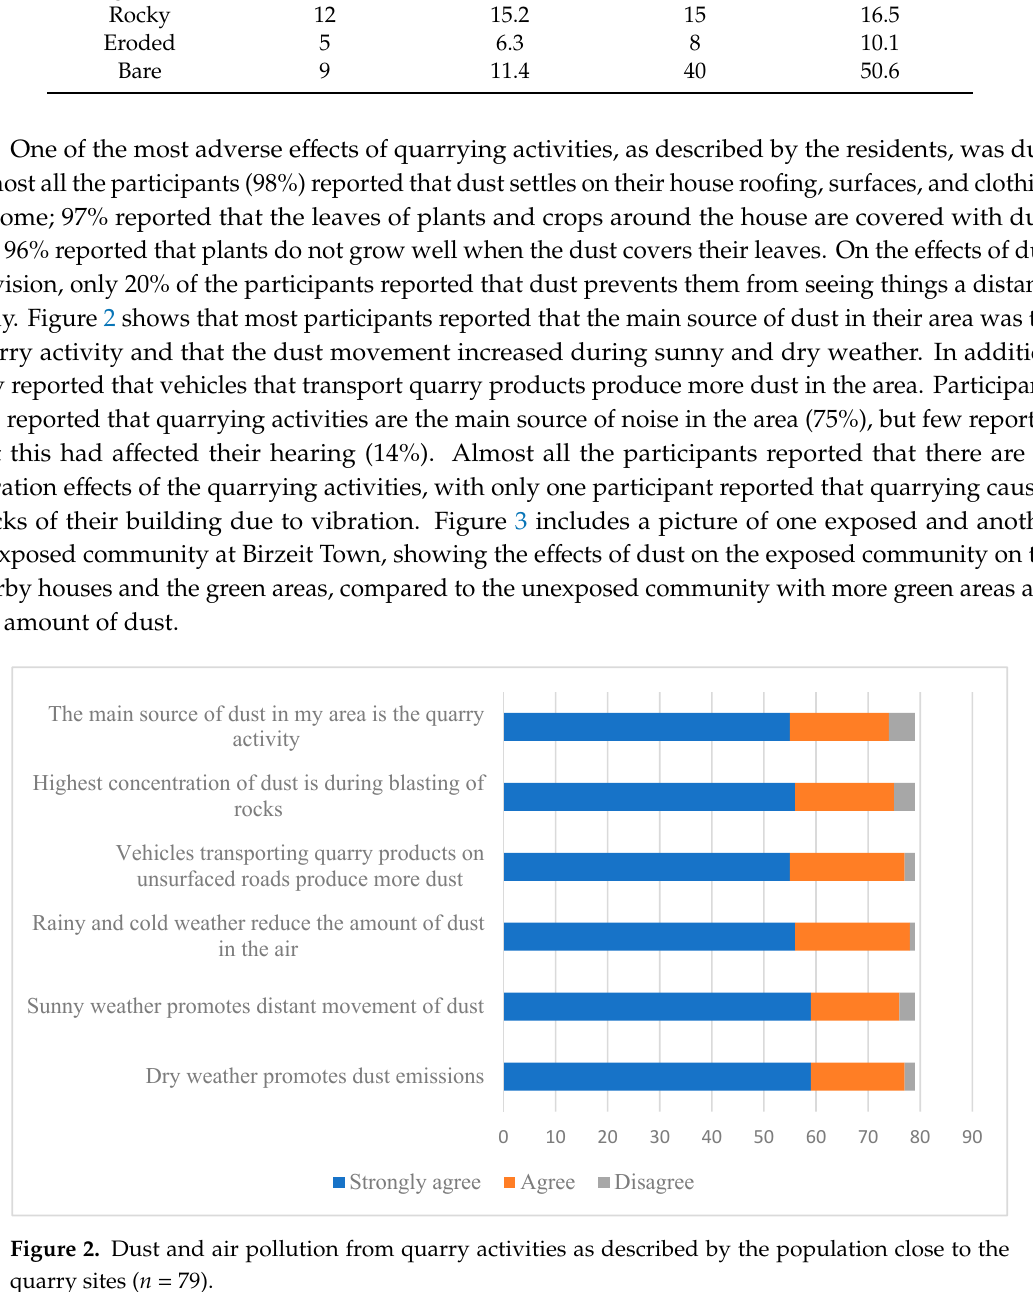
Figure 3. Pictures of exposed and unexposed communities at Birzeit Town. 3.2. Reported Symptoms and Diseases The exposed group reported more rhinitis (13% vs. 3%), eye or nasal allergy (22% vs. 3%), and irritant eye symptoms including tearing (19% vs. 1%), soreness (18% vs. 1%), and dryness of the eye (17% vs. 3%) compared to the control group, Table 3. Asthma and bronchitis were reported by two